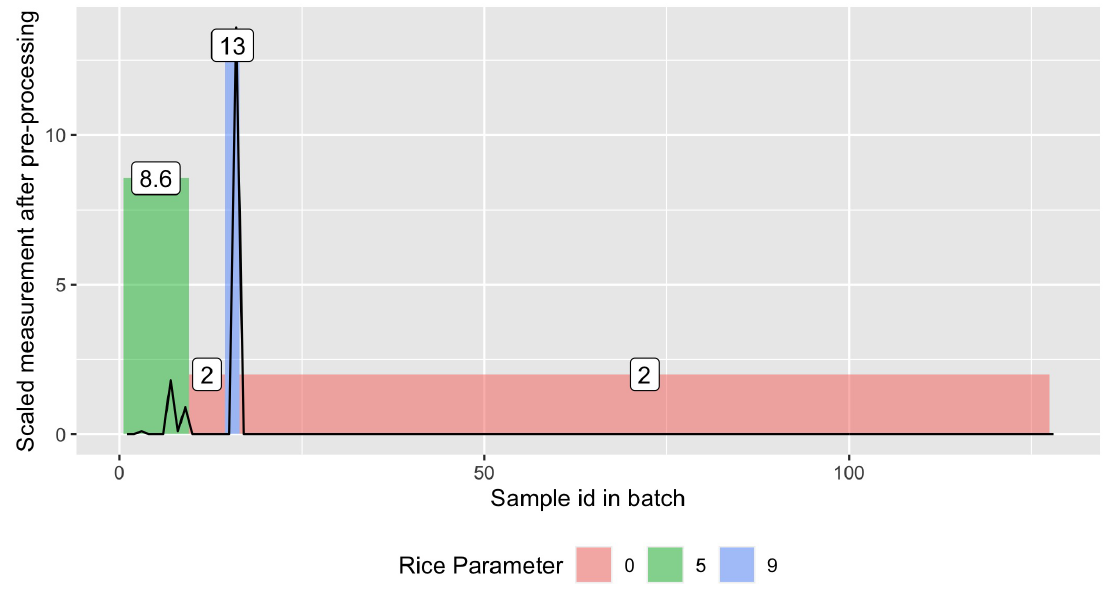
Figure 7. Scaled sequential difference of 128 measurements of interval rain from the 63rd Street Weather Station in Chicago, USA, between 09:00:00 and 19:00:00 local time on 1 March 2017. The continuous (black) line represents the sequence of measurements over time. The shaded (coloured) boxes